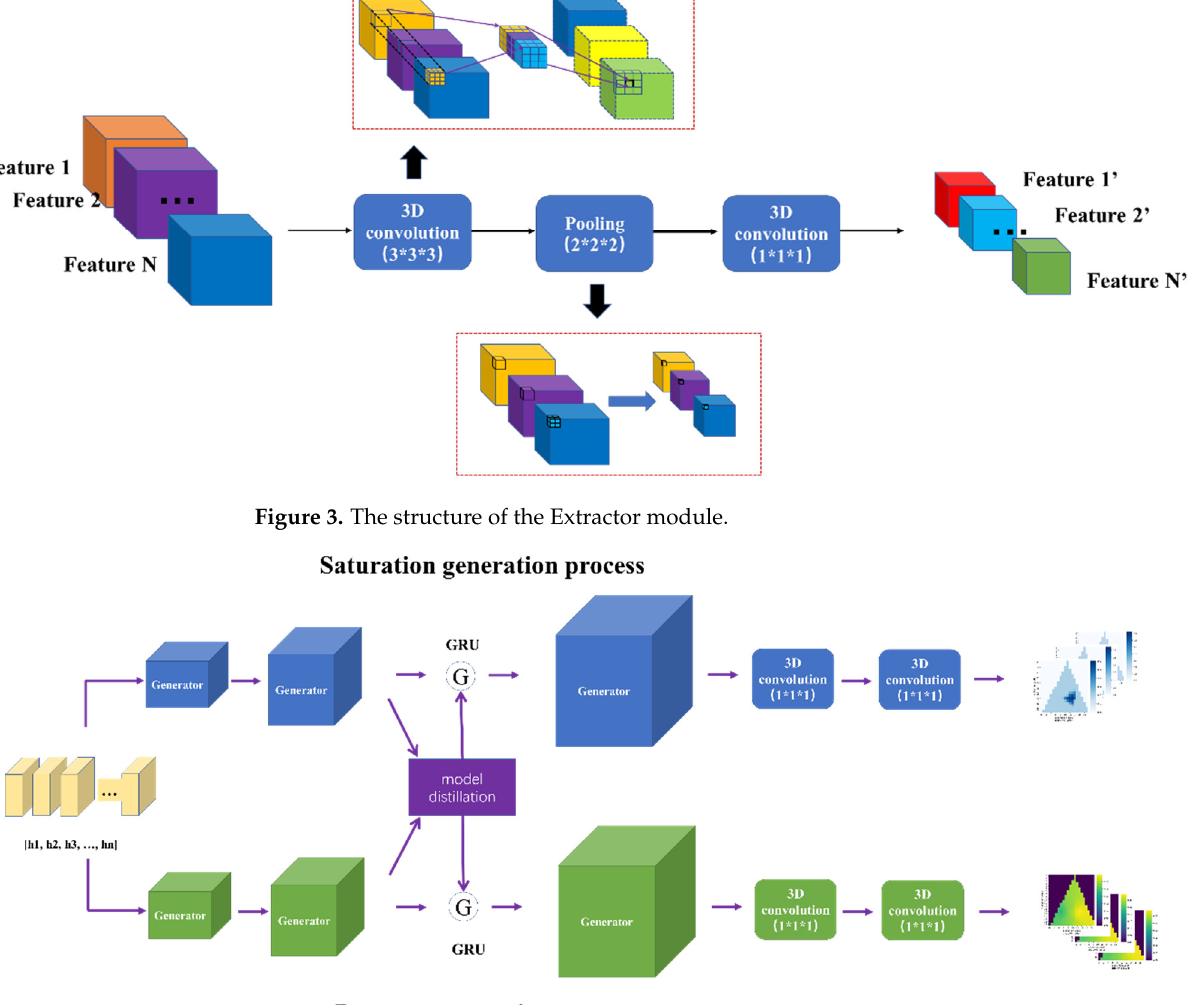
Figure 5. The structure of the generator.   = (  ∗   +   ∗   )